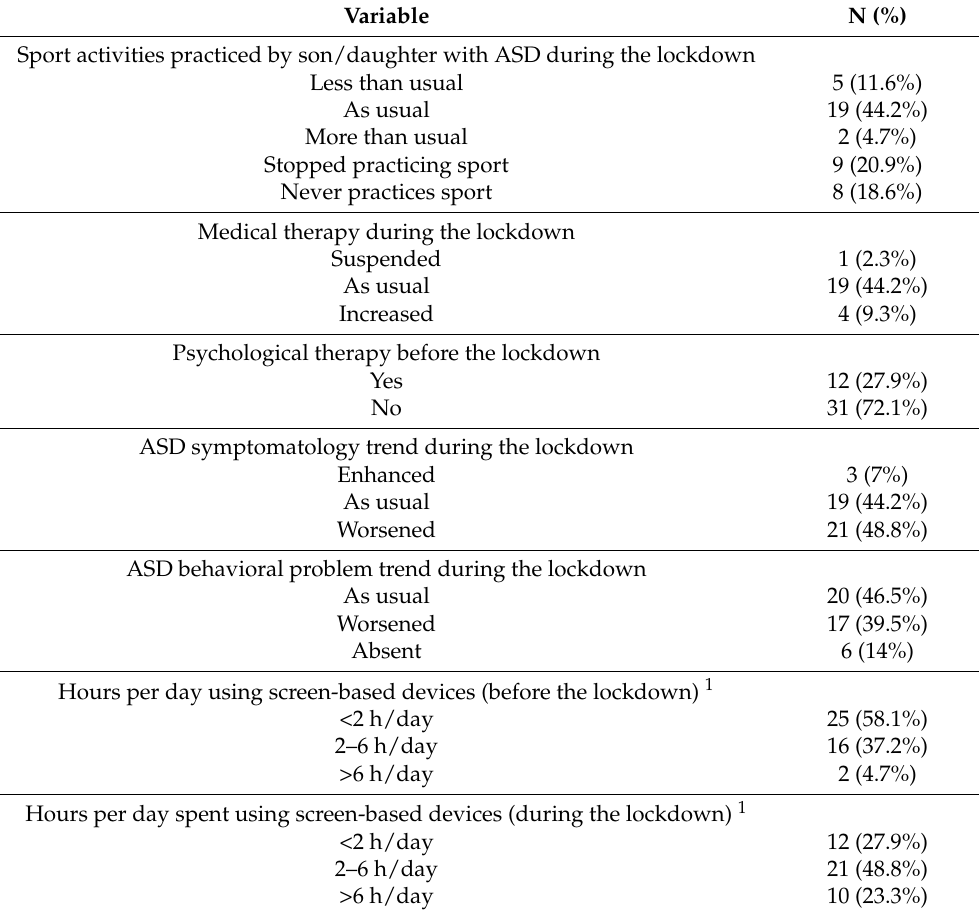
Table 3. Parent-reported sociodemographic information regarding adults with ASD. Variable N